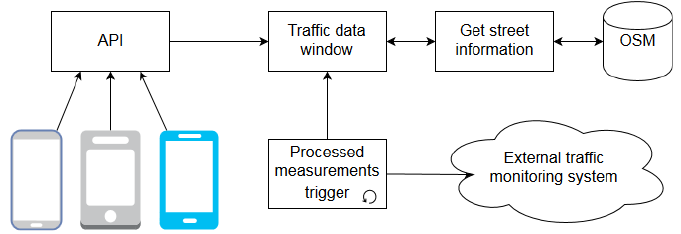
Figure 7. Traffic data collector